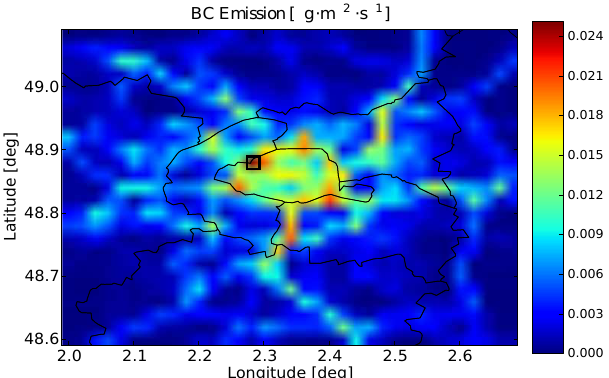
Figure 5. BC emissions over Greater Paris at 02:00UT, 1 July 2009.